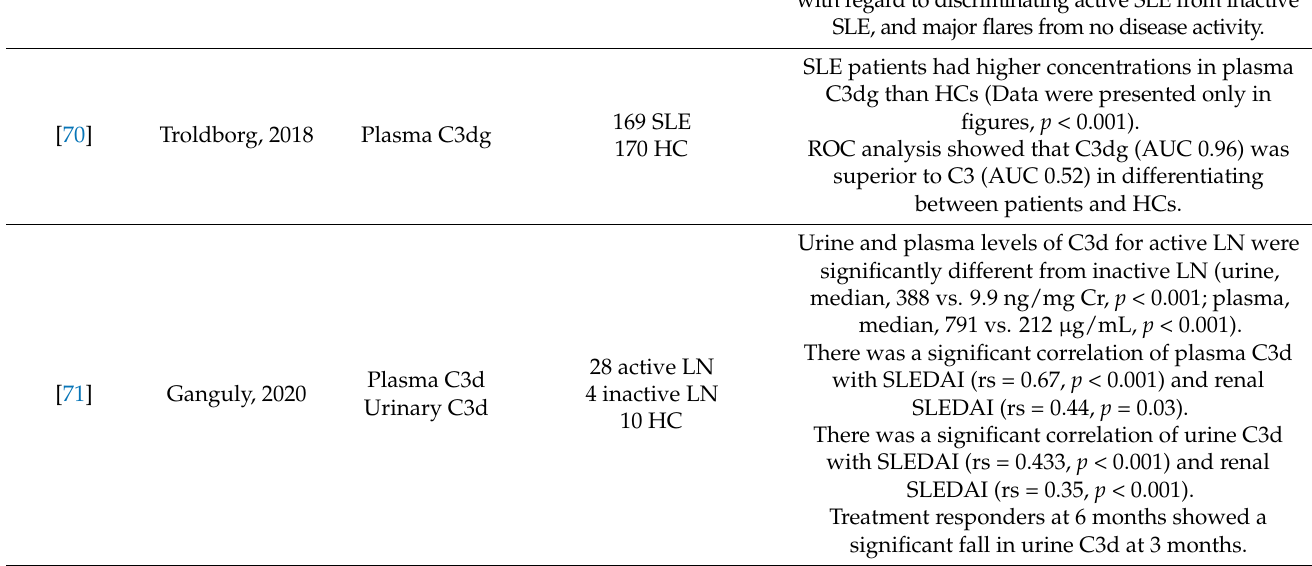
The iC3b:C3 ratio outperformed C3 and C4